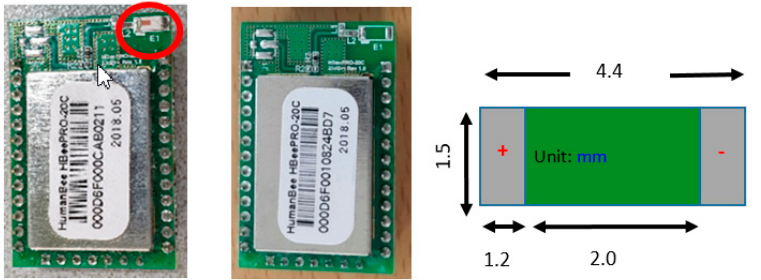
Figure 2. RF module, location of antenna, and size of the feeding point of an inverted F antenna.